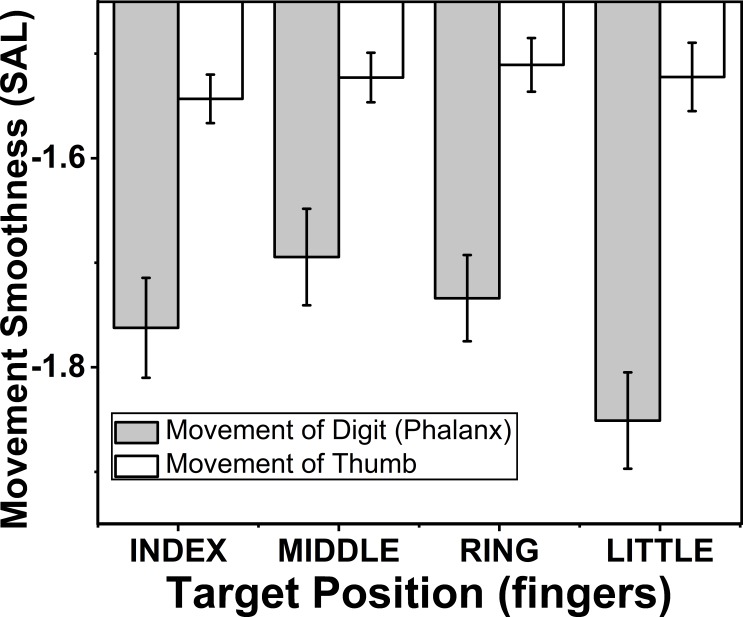
Change of smoothness of phalanx and thumb for different target fingers.The smoothness of the movement of fingers and thumb was determined using spectral arc length method, when the spectral arc length value was large, smoothness of the movement was less. The smoothness of the phalanx movement reduced significantly (p < 0.01), when target position was changed from index to little finger. There was no significant difference of smoothness of thumb movement. When target position was changed. The columns and bars indicate means and standard error of means.